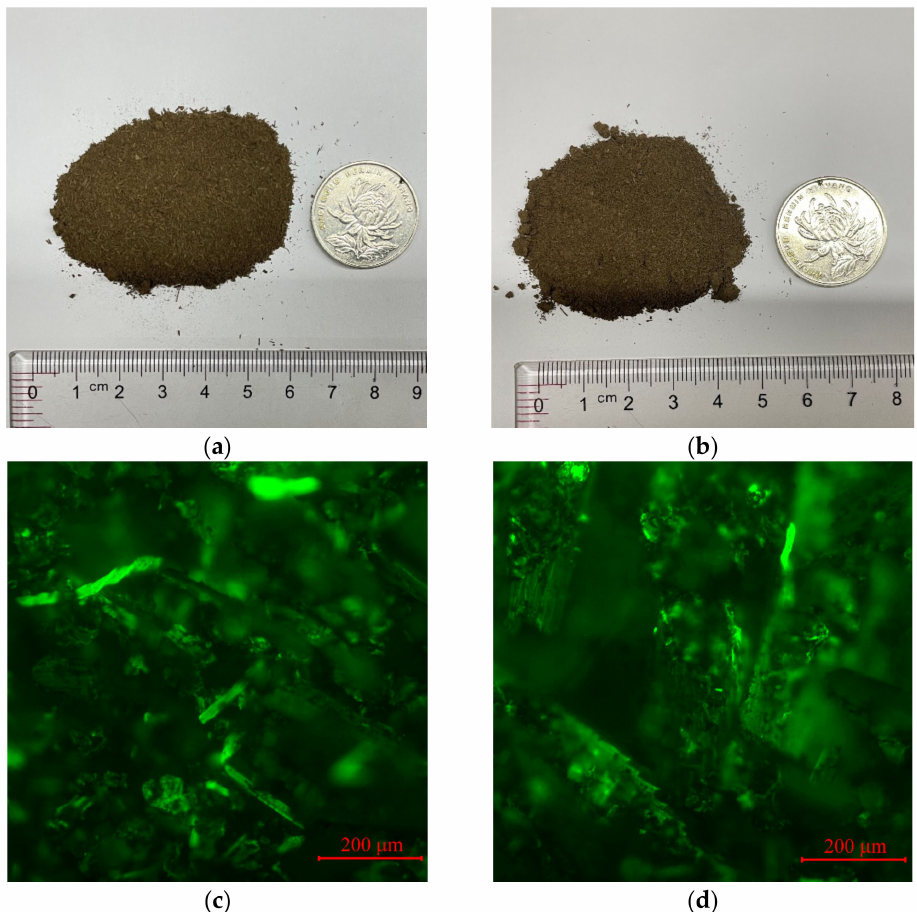
Figure 1. Hydrochar modifiers: ( a ) hydrochar A (HA) and ( b ) hydrochar B (HB); FM images of ( c ) HA and ( d ) HB.